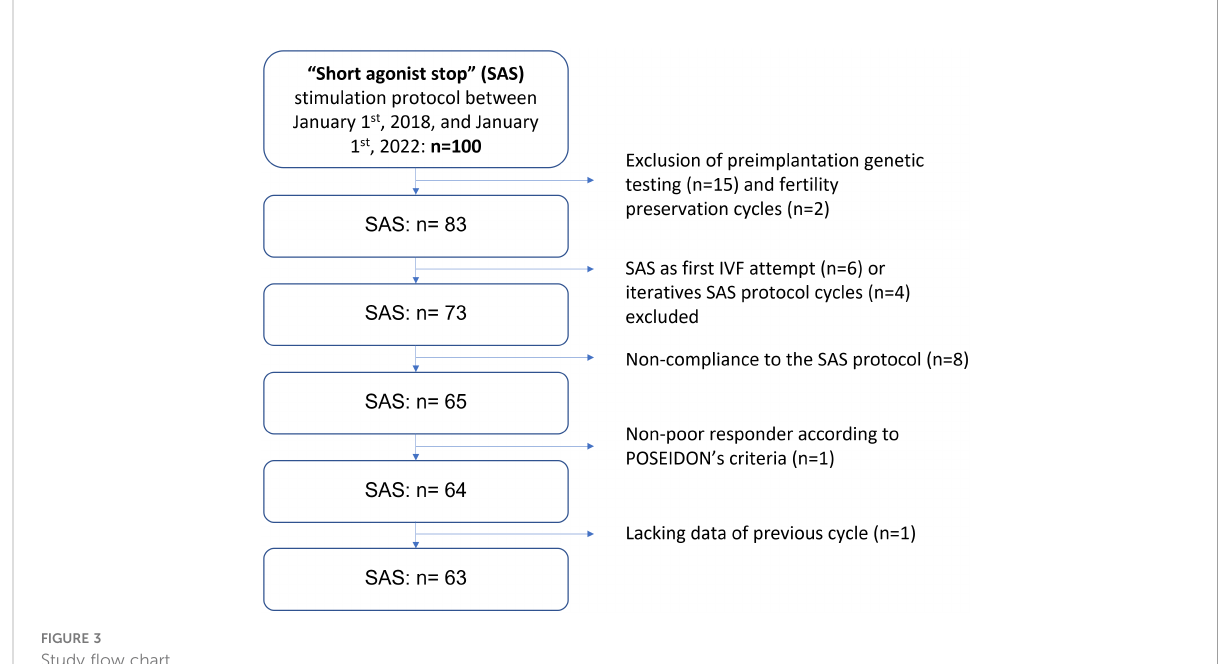
FIGURE 3 Study fl ow chart.